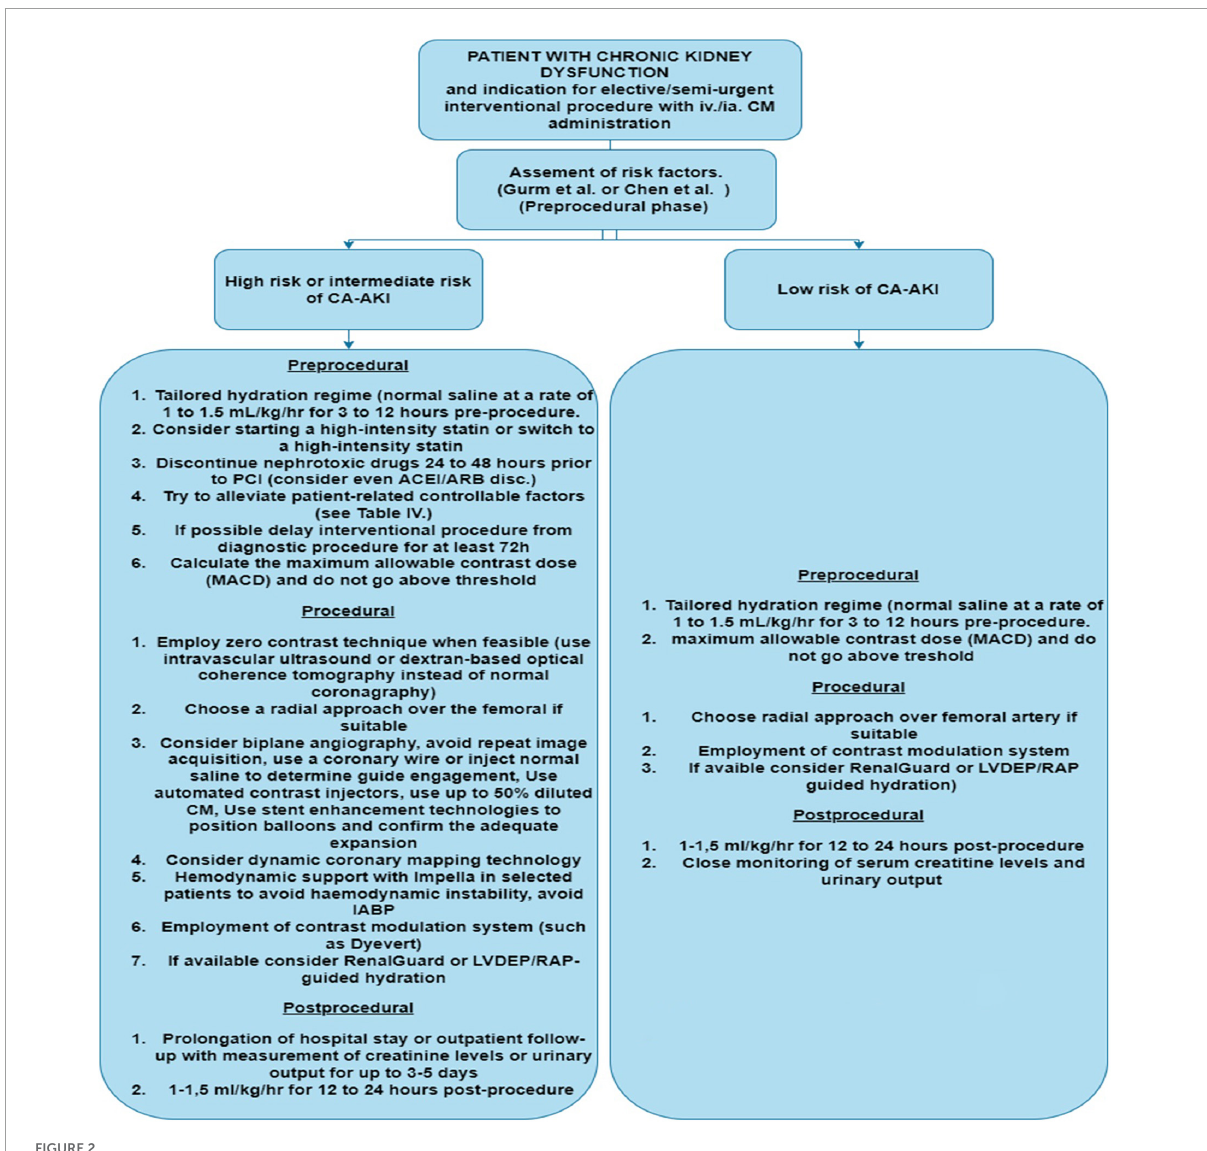
FIGURE2 Diagram for Cl-AKI prevention and patient approach.LVDEP, left ventricle end-diastolic pressure; RAP, right atrial pressure; IABP, intra-aortic balloon pump; CM, contrast media; CA-AKI, contrast associated acute kidney